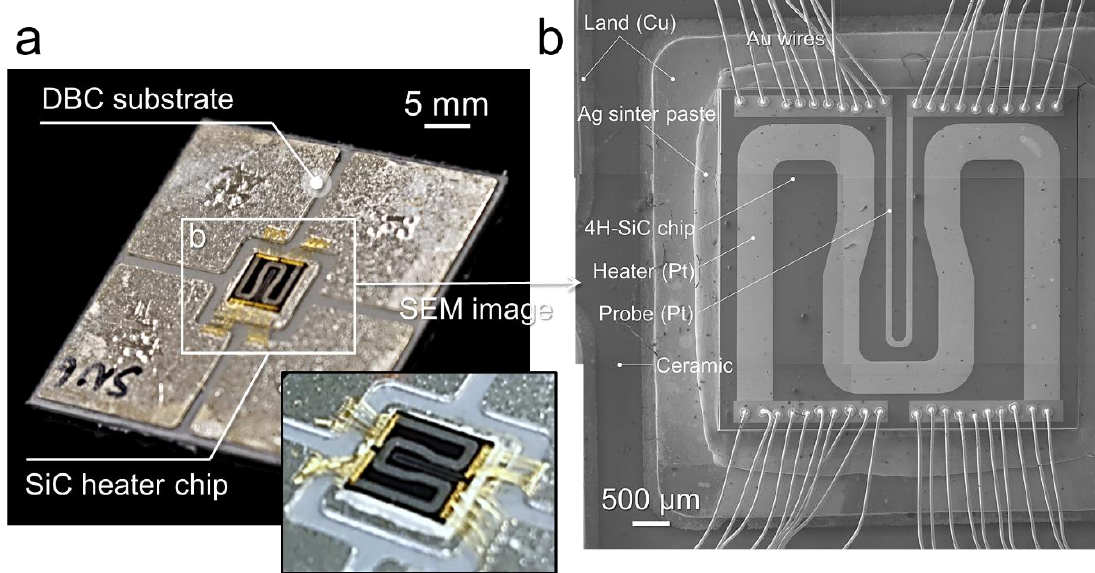
Figure 5. Test specimen description: ( a ) interconnected SiC heater chip on direct bonded copper (DBC) substrate and ( b ) its SEM image of detail components.